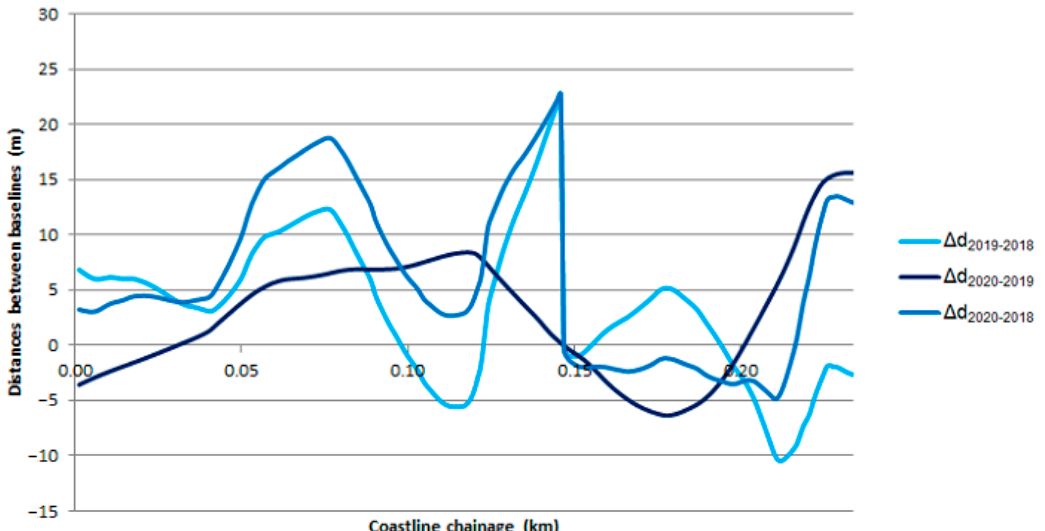
Figure 10. Distances between TSBs of the waterbody located at the approach to Górki Zachodnie from the Gda ń sk Bay measured with the hydrographic method in 2018–2020.